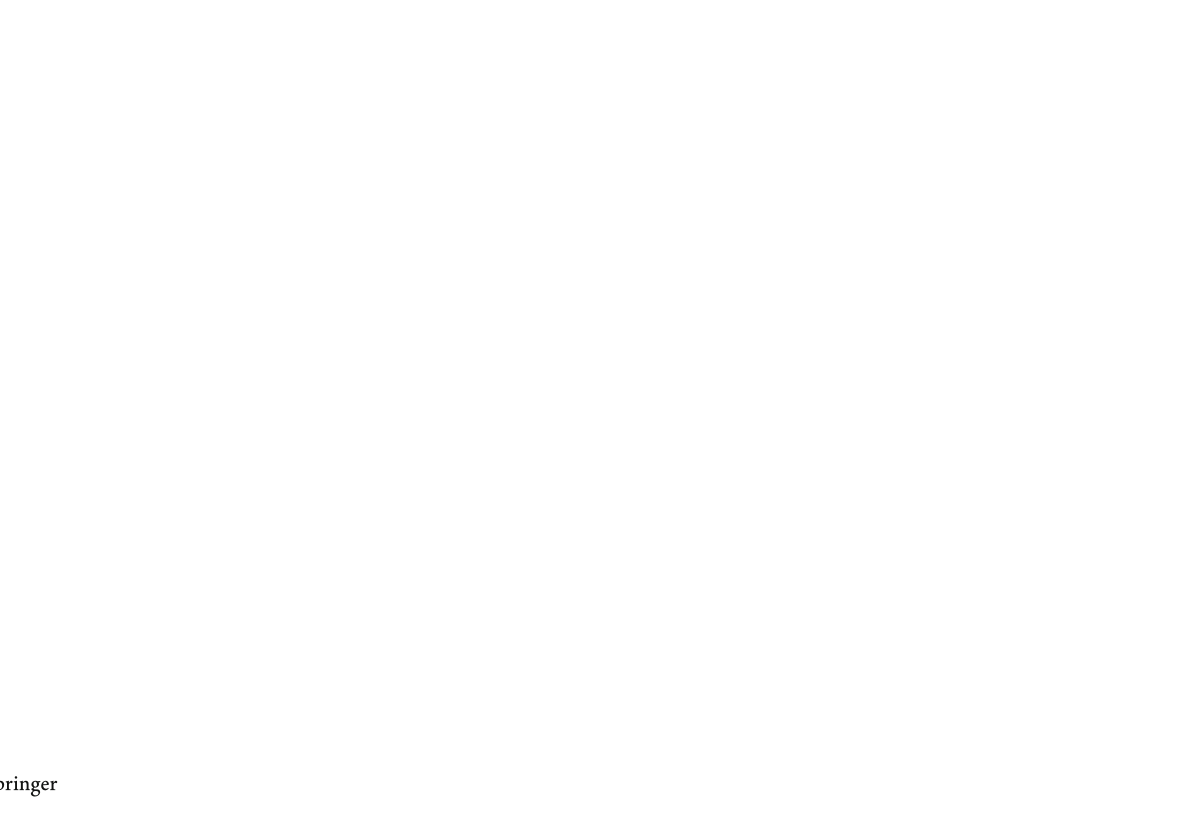
vectorsaretriviallyextendedfromTables1and3respectively.Formore information on the various forms of the four-gluon vertex, see Sect. 5.1 in [1]. The color factors are normalized such that Tr